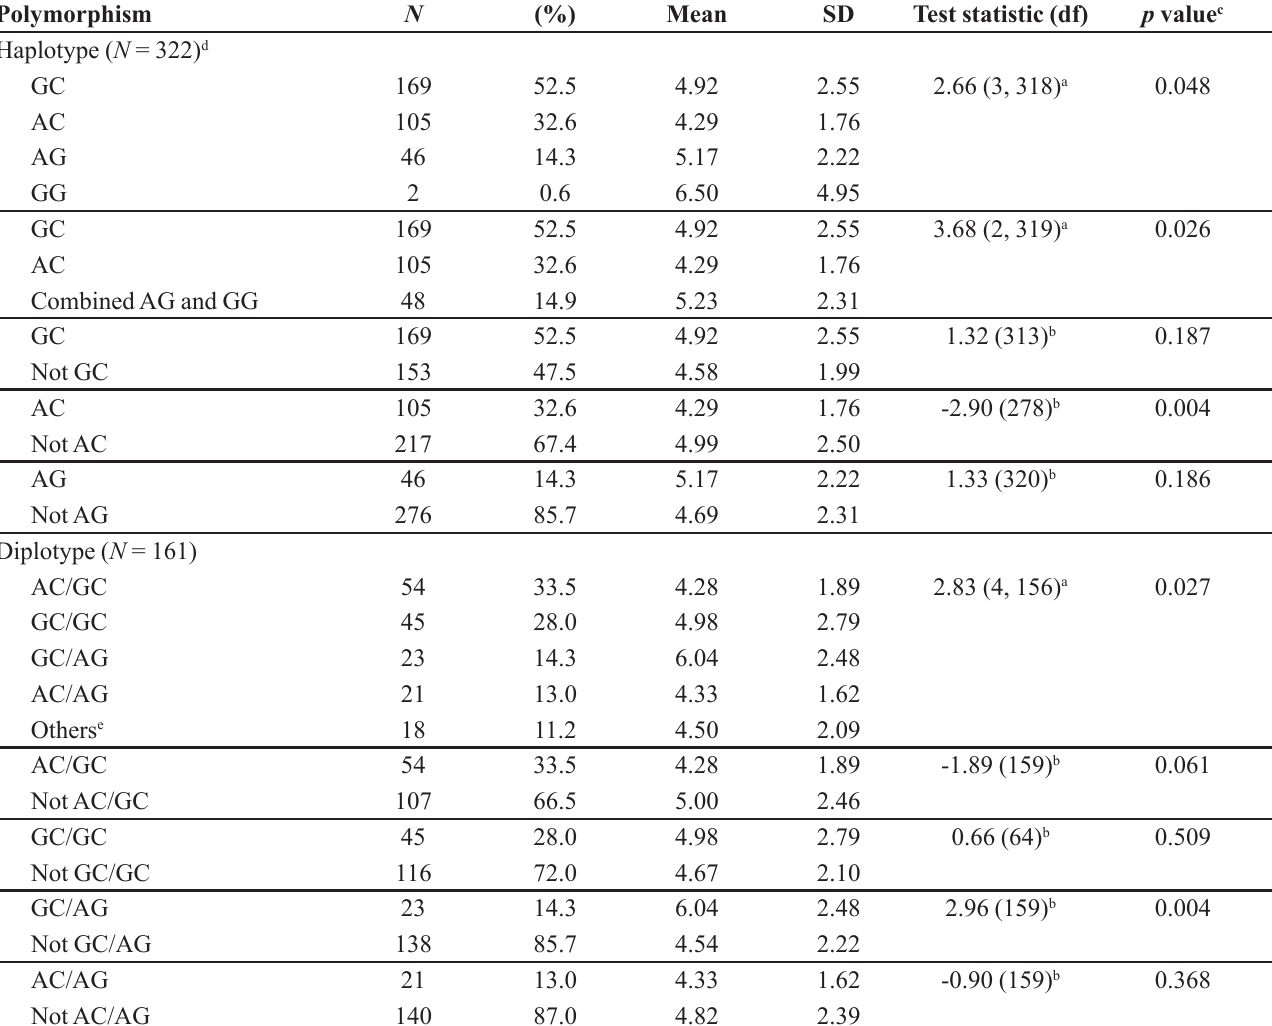
TABLE I - Association between 118A>G and IVS2+691G>C polymorphisms and PSQI scores in opioid-naive Malay Males